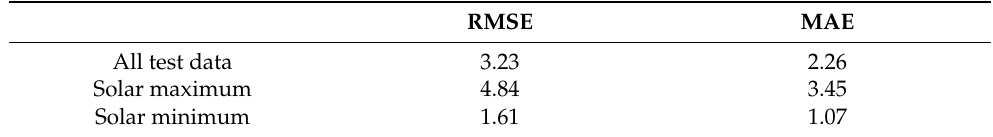
Table 6. Annual mean RMSE and MAE values (TECU) between 12 TEC maps for the past day and 12 TEC maps for the future day during high and low solar activity